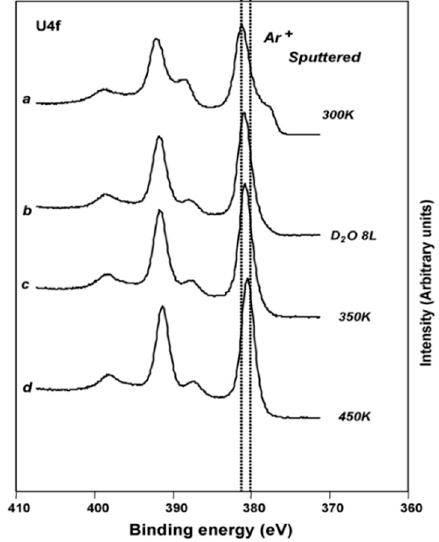
Figure 6. XPS spectra of reduced UO 2 (111) surface after exposure to D 2 O [45].